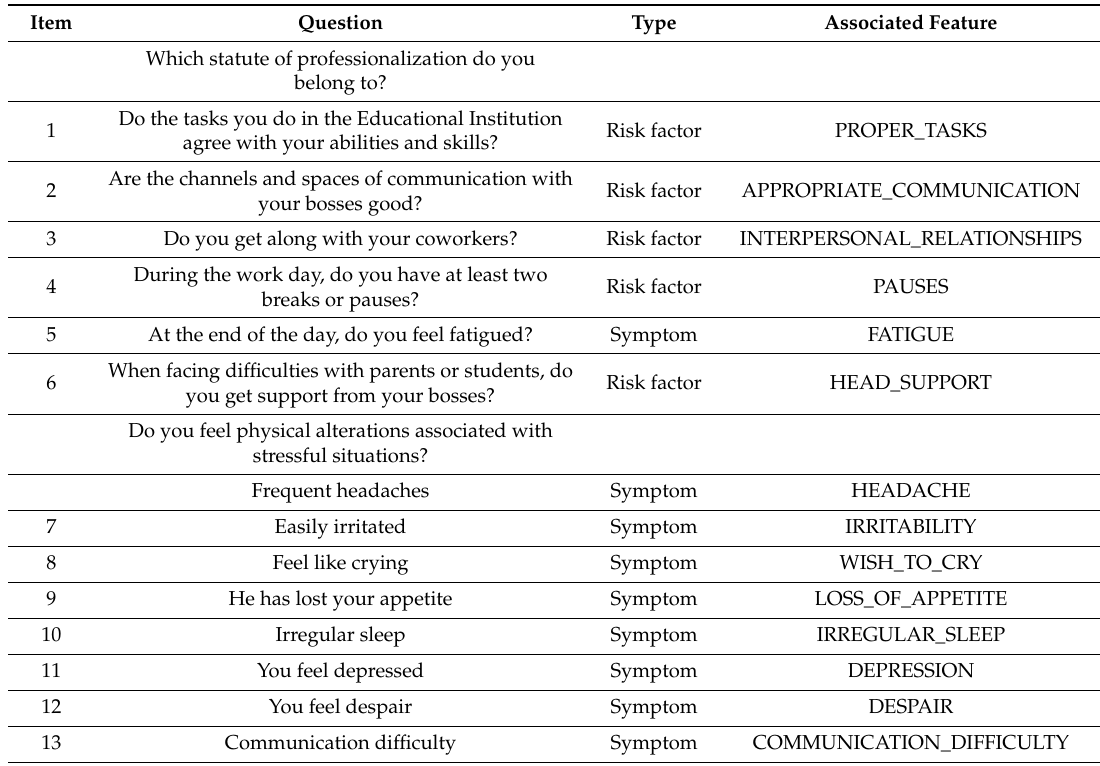
Table 1. Questions of the survey instrument, with associated label, and type of question (risk factor or